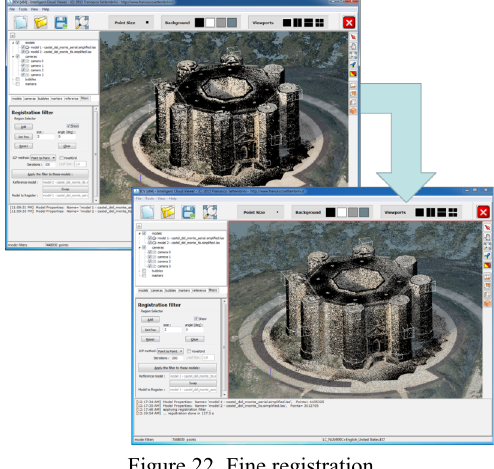
Figure 22. Fine registration